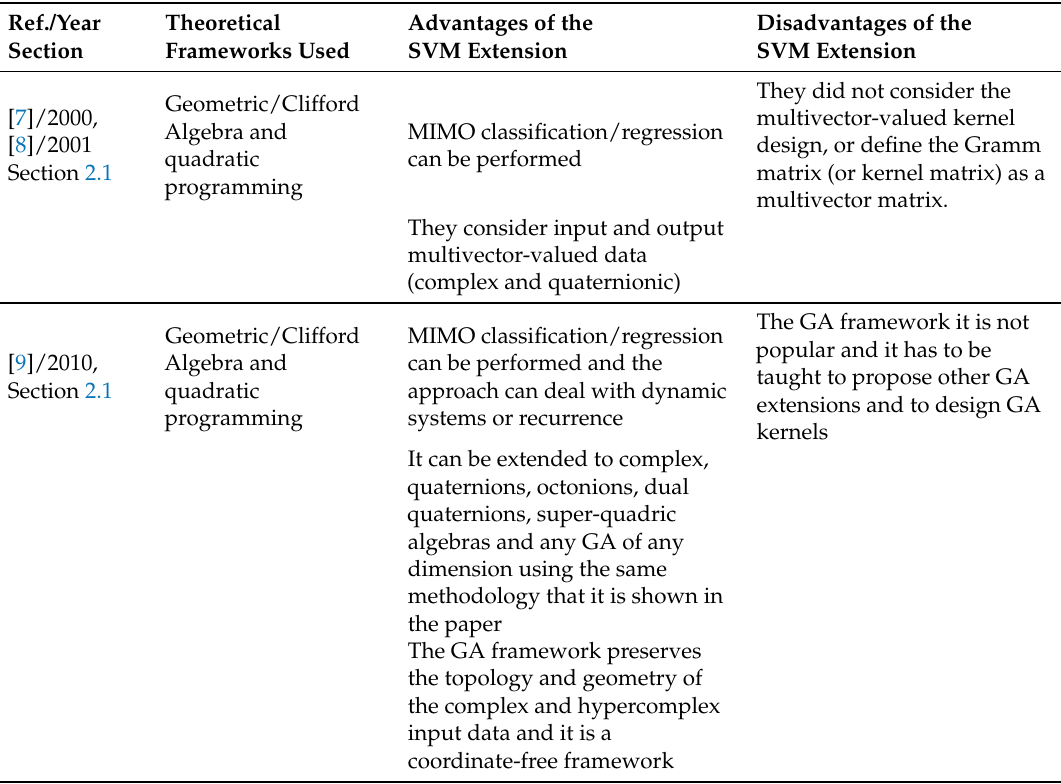
Table 1. Part 1-Complex and hypercomplex SVM